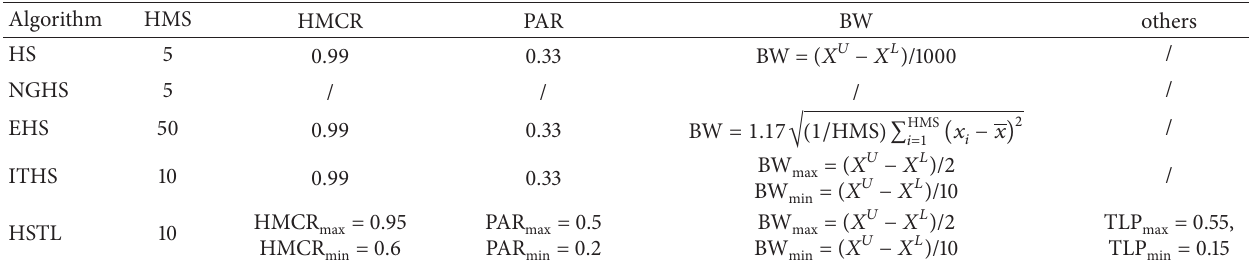
Table 2: Parameter settings for the compared HS algorithms (HS, NGHS, EHS, ITHS, and HSTL). Algorithm